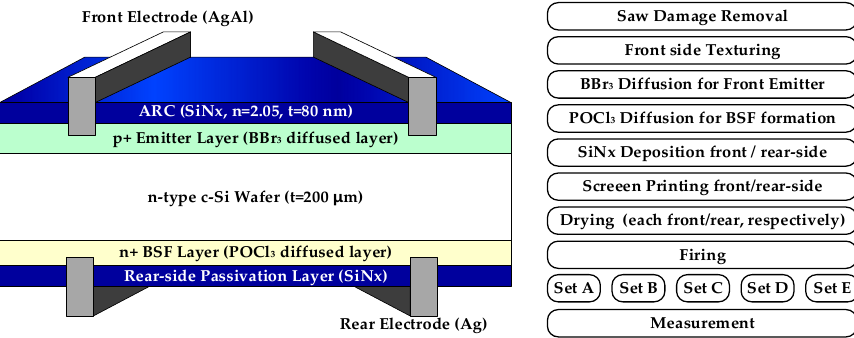
Figure 1. Schematic of the solar cell structure and process flow used in this study. Table 1. Fast-firing temperature profile groups of this study.